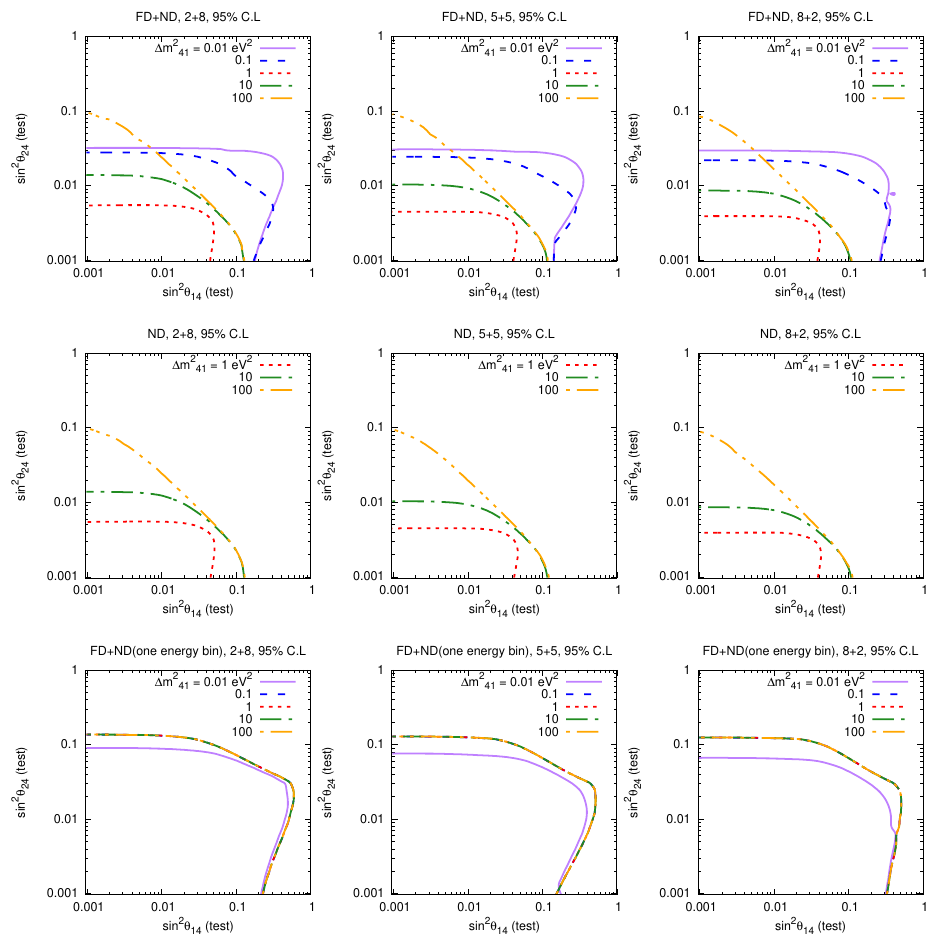
2 (cid:18) 14 (test){sin 24 (test)